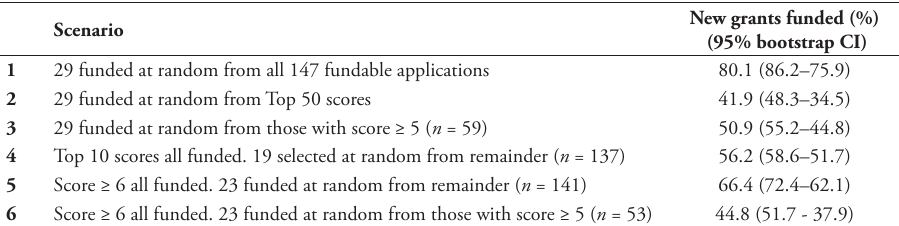
Table 2. The effect of using different random selections by including new awardees from those previously funded in Year 8 of the anonymous United Kingdom funding body